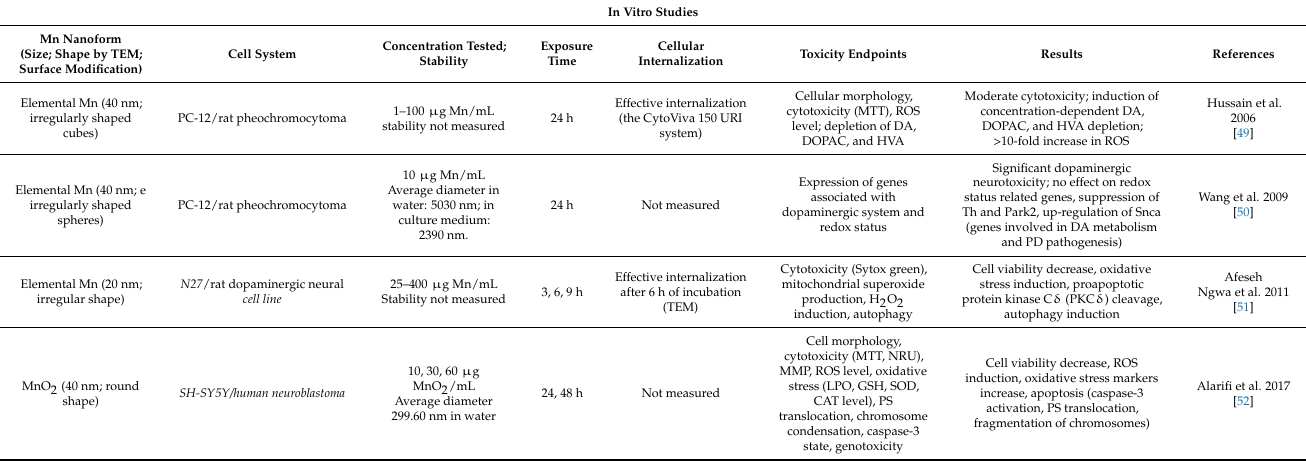
Table 2. Summary of in vitro and in vivo studies performed on different nanoforms of manganese and manganese